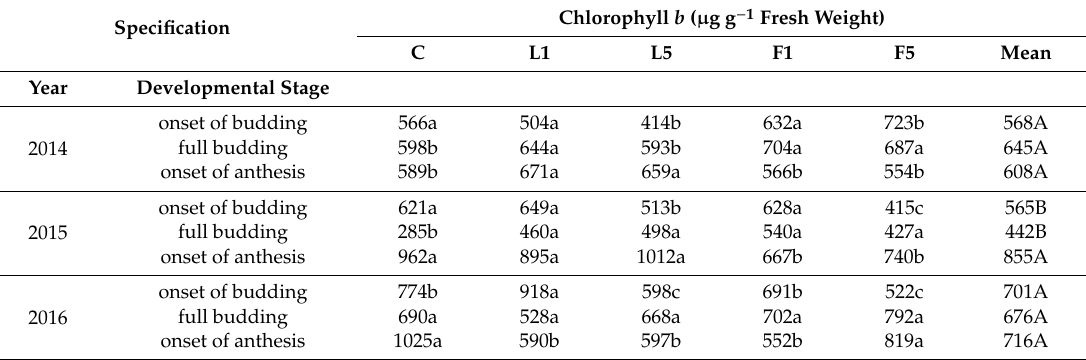
Table 5. Influence of electromagnetic stimulation on chlorophyll b content.